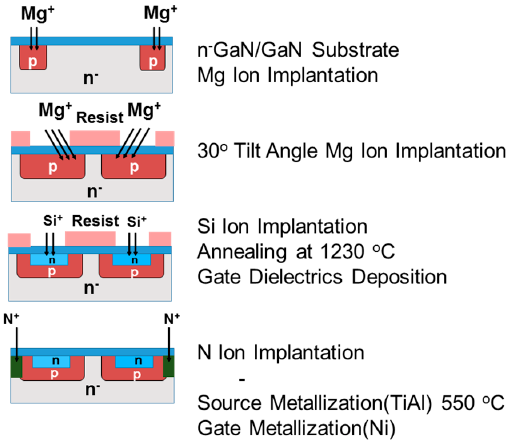
Figure 5. Fabrication process of the GaN DMOSFET by triple ion implantation.